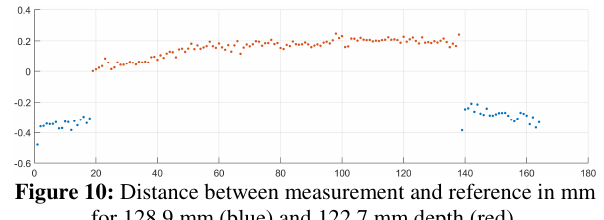
Figure 10: Distance between measurement and reference in mm for 128.9 mm (blue) and 122.7 mm depth